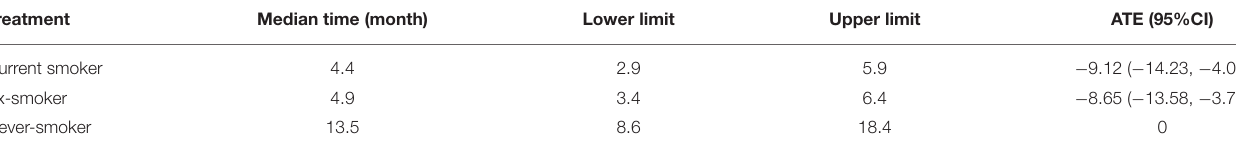
TABLE 4 | Time to MACE among smoking groups: a propensity score model.